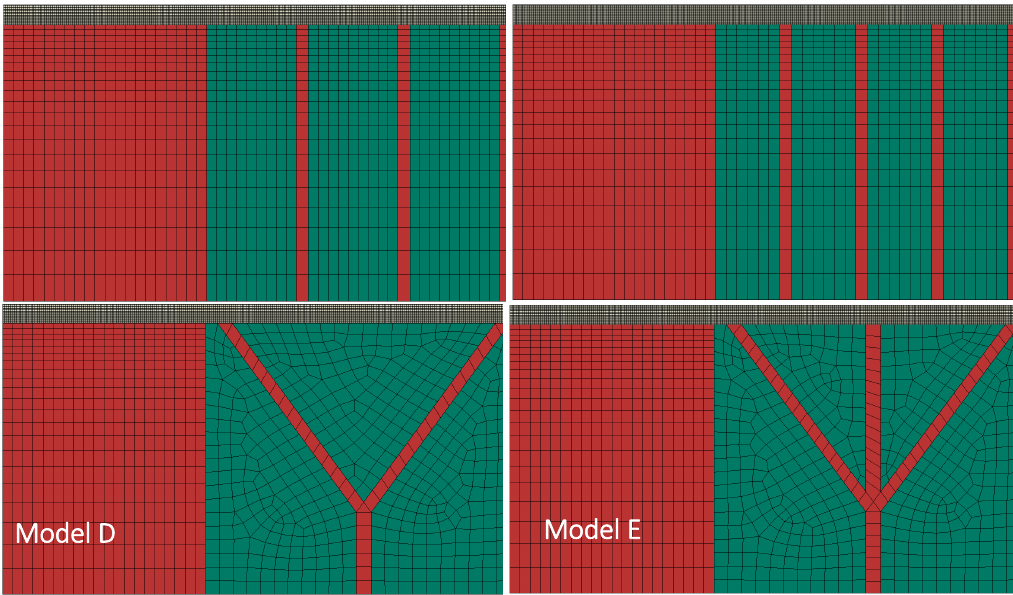
Figure 6. FE models with different support structures.